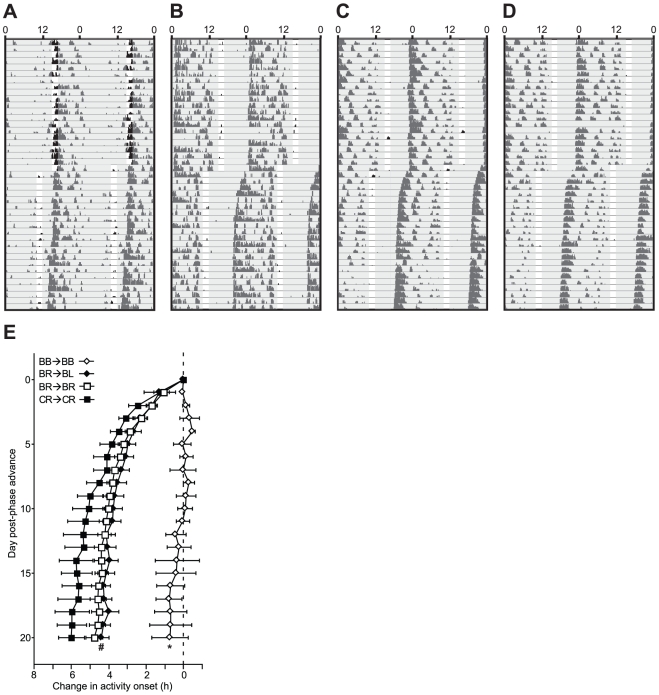
Light-induced phase shifts of the circadian locomotor activity rhythm after occluder reassignment.
A–D Representative double-plotted locomotor activity records of Syrian hamsters bearing: A occluders in both eyes (BB→BB), B an occluder in the right eye (BR→BR), C an occluder that was moved from the right eye to the left on week 10 (BR→BL), and D a clear lens in the right eye (CR→CR). Clock time is indicated on the horizontal axis along the top of each actogram. Lights on/off are indicated by light and shaded areas of the actogram. E Mean (± s.e.m.) daily locomotor activity onsets of hamsters bearing ocular occluders during the 3 weeks immediately following a 5-hour phase advance of the light-dark cycle. * p<0.05 vs. all other groups, # p<0.05 vs. the CR-CR group.